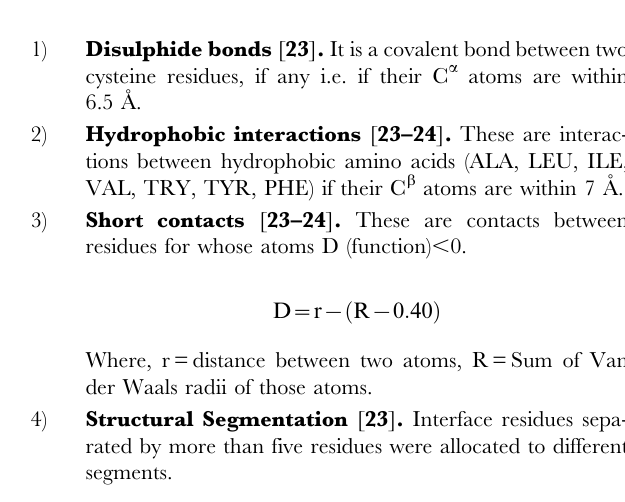
Table 2. Propensities of amino acids to be in alpha-helix, beta-sheets, loops and hinge.